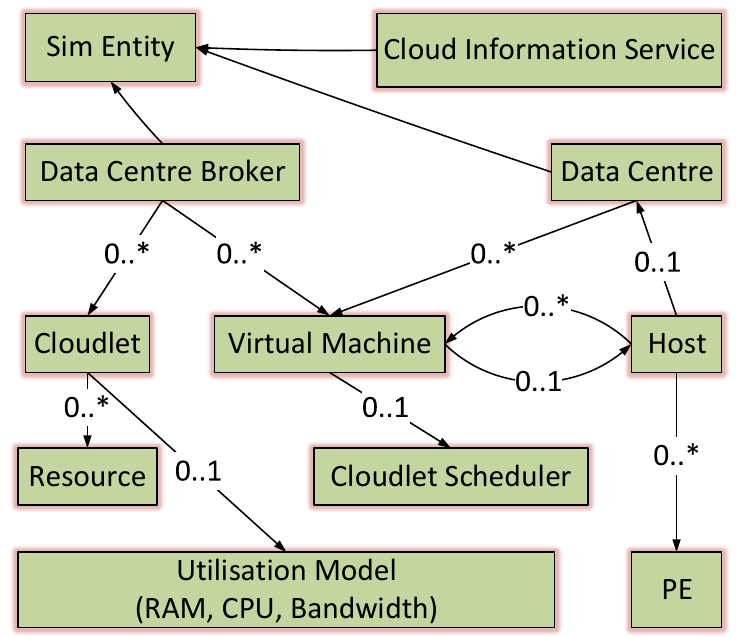
Figure 1. CloudSim component overview.